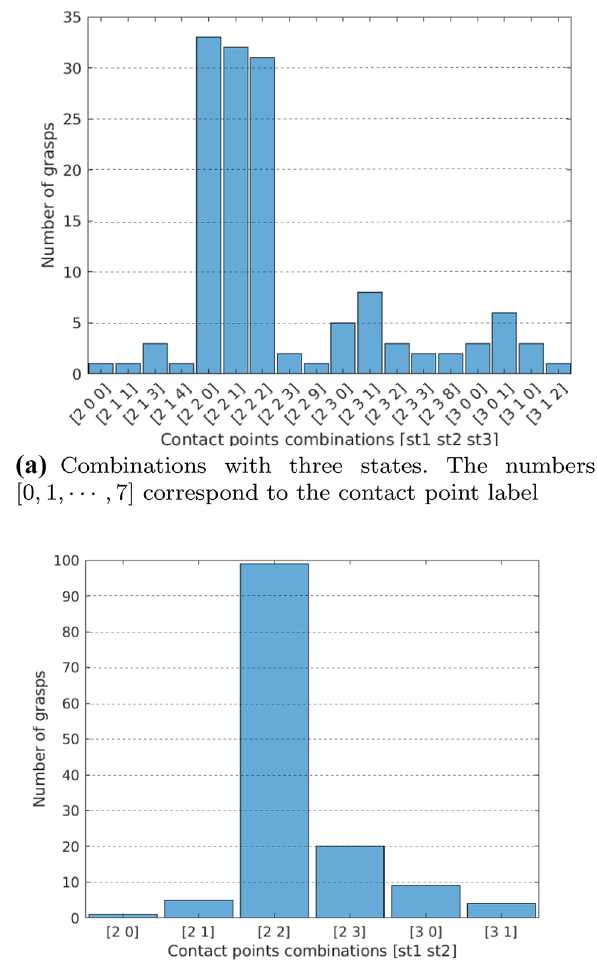
Fig. 3 Histogram of the combination states for two and three